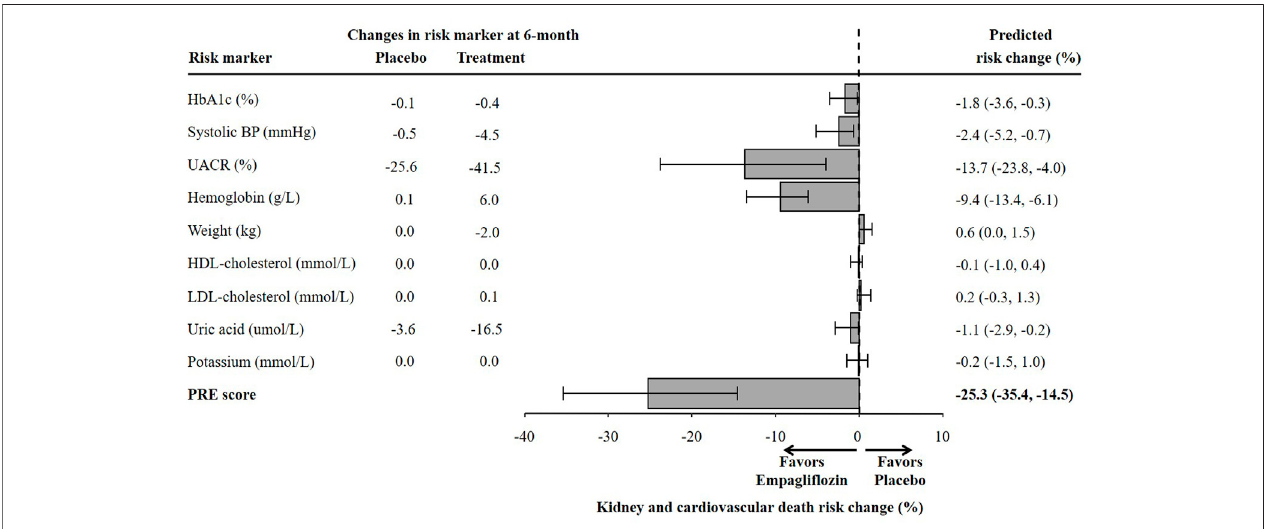
Frontiers in Pharmacology |